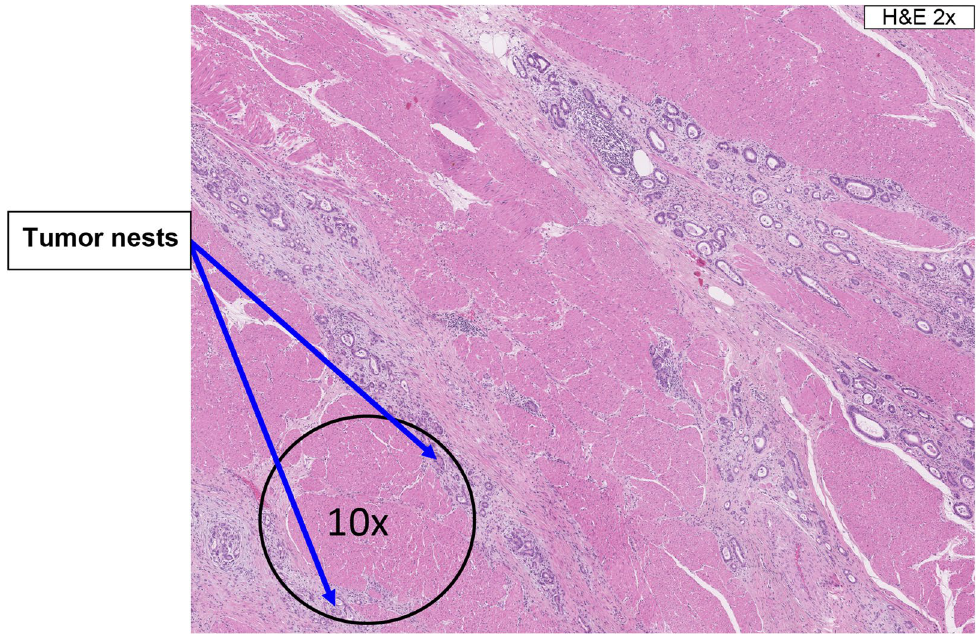
Fig. 2 10x field rule: if tumor nests are separated by non-neoplastic tissue, they are included as part of the tumor area as long as the tumor nests are bordered on both sides of a 10x field; the intervening non-neoplastic tissue is also included in the tumor area. H&E hematoxylin and